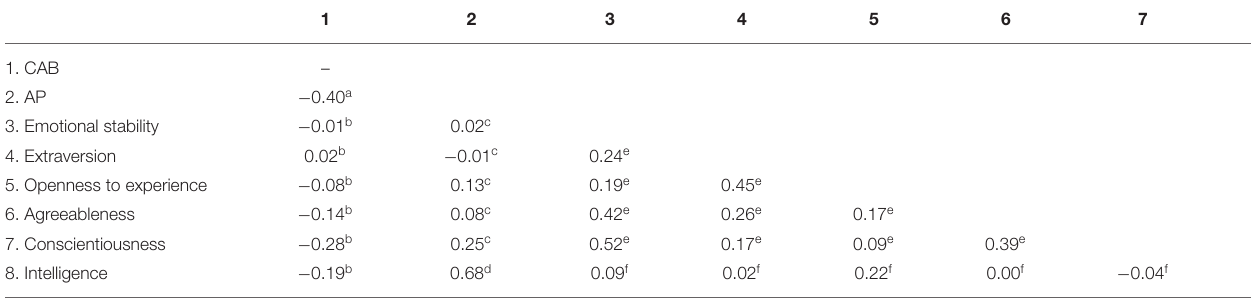
TABLE 6 | Matrix of meta-analytical correlations used for the path analysis ( N = 12,087).